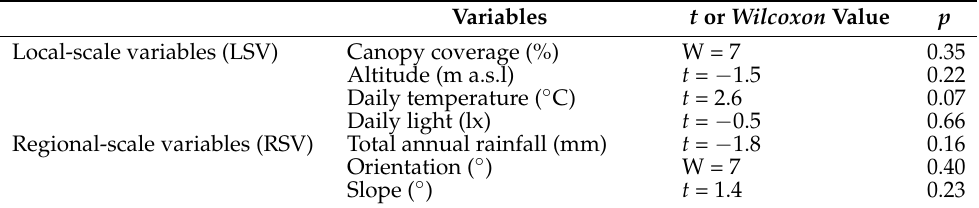
Table 3. Local and regional variables comparison between managed and conserved sites using T-student or Wilcoxon test. Variables t or Wilcoxon Value p Local-scale variables (LSV) Canopy coverage (%) W =